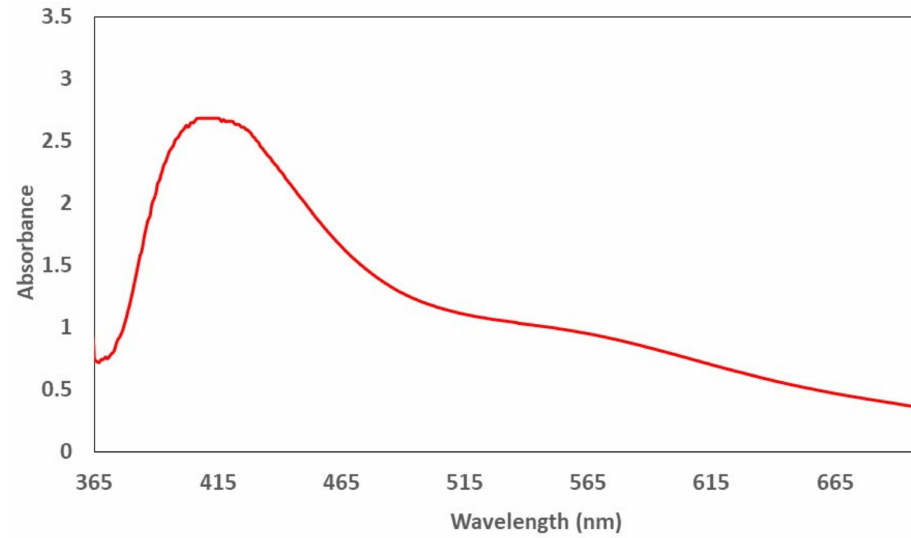
Figure 1. UV-Vis spectral range showing a peak of ZOE-AgNPs at 415 nm.